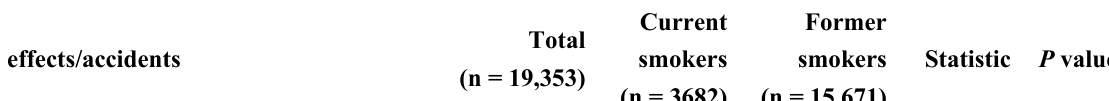
Table 6. Changes in disease conditions after electronic cigarette use